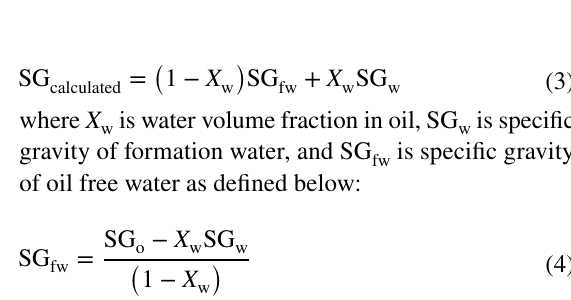
The constants of a 1 , b 1 , a 2 , and b 2 are referenced from PSME of UPN “Veteran” Yogyakarta collaborated with LEMIGAS Jakarta (2017)